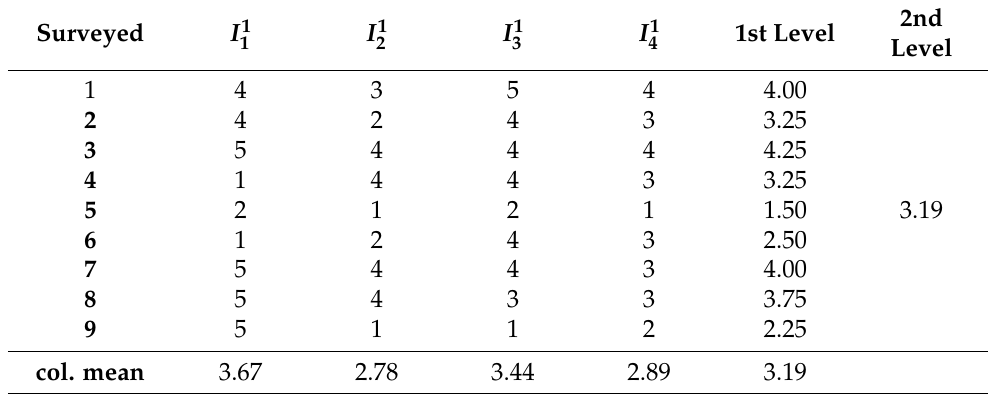
Table 2. Responses and aggregate values for the two questions of the